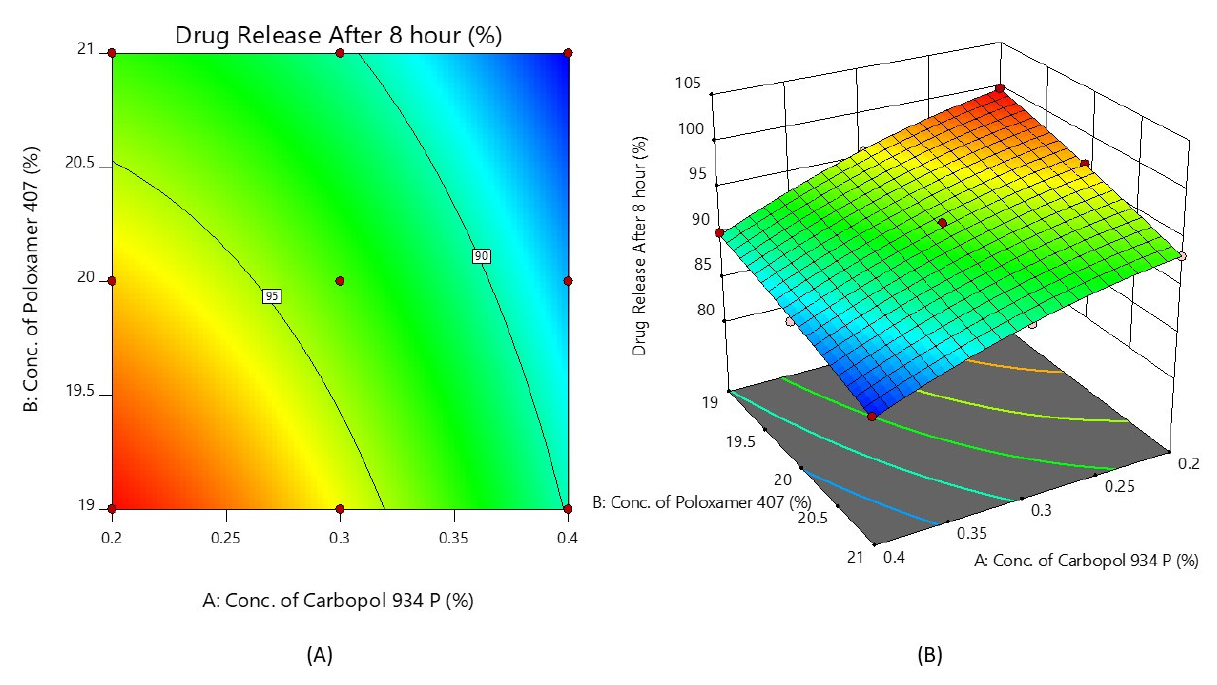
Figure 5. Contour plot ( A ) and 3D surface plot ( B ) show the effects of the concentrations of Carbopol 934P and Poloxamer 407 on drug release after 8 h.